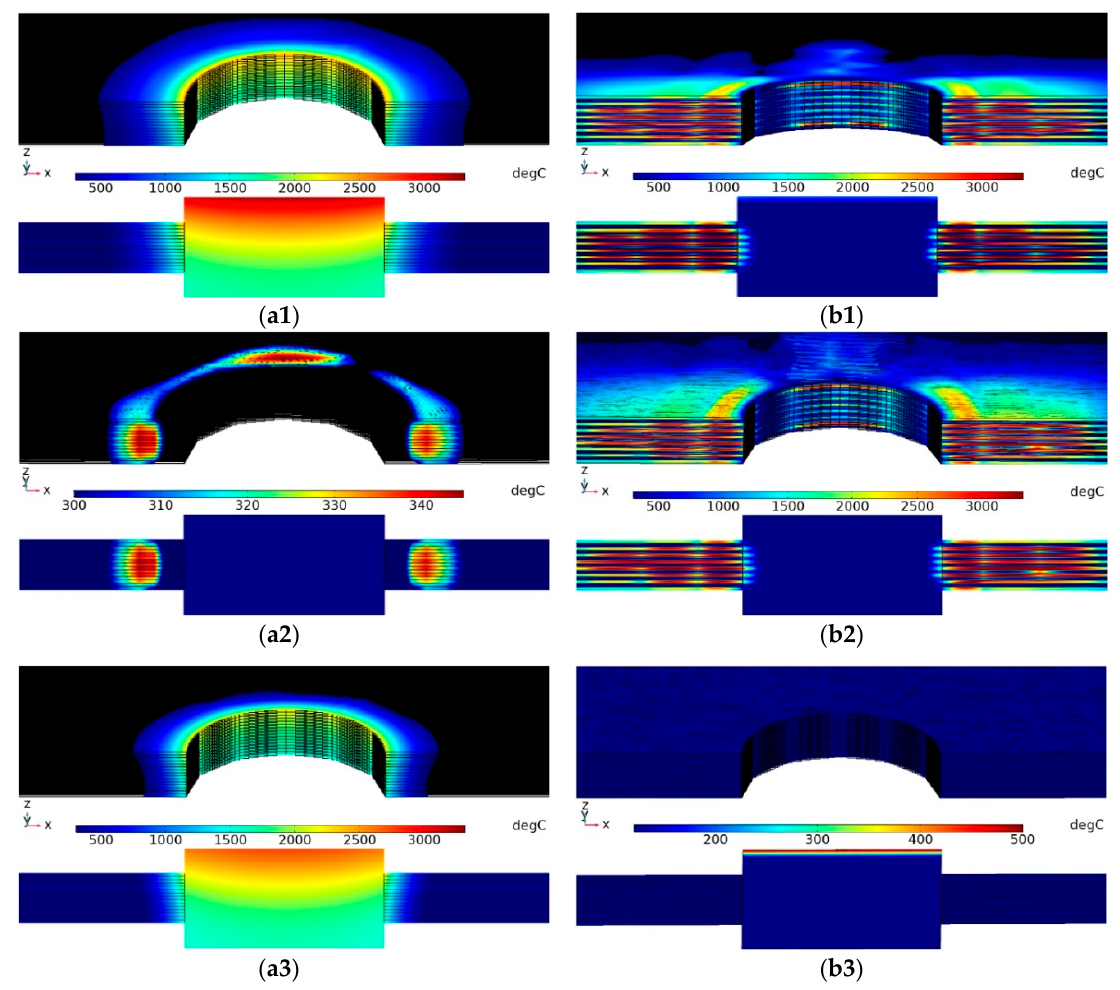
Figure 9. Cross-sectional temperature profiles of the fastener hole under different simulation models and different lightning current components: component C in the ( a1 ) conduction current + heat flux model, ( a2 ) conduction current model, and ( a3 ) heat flux model; component D in the ( b1 ) conduction current + heat flux model, ( b2 ) conduction current model, and ( b3 ) heat flux model.